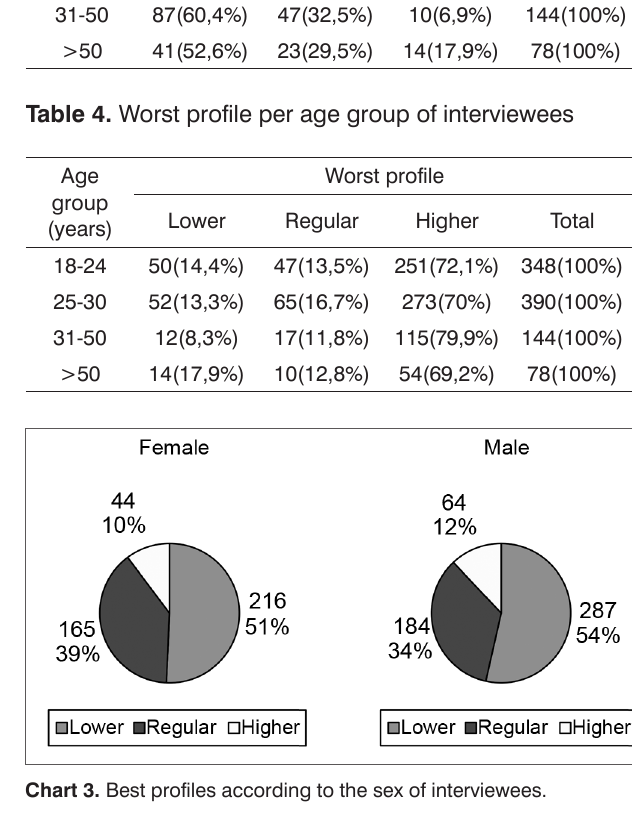
Table 2. Worst profile per interviewee group Lower Regular